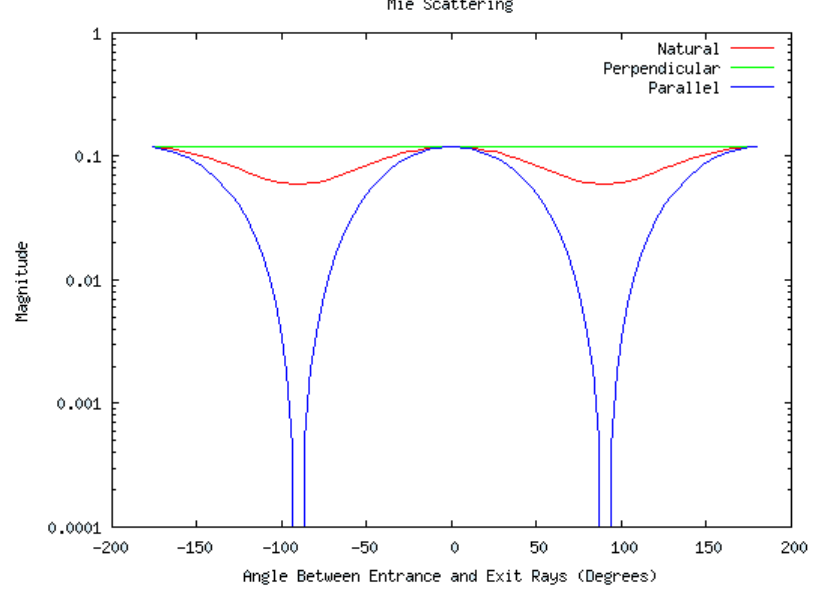
Figure 5. Mie scattering prediction curves for ratios {0.008, 0.014, 0.020} (cylinder-diameter to wavelength ratio) for the frequencies {914, 1720, 2450 MHz} respectively. We note here the natural curve in red is un-polarized radiation. Also of interest is the imaging antennas are in parallel polarization to the infinite cylinder model (metal bale ties).